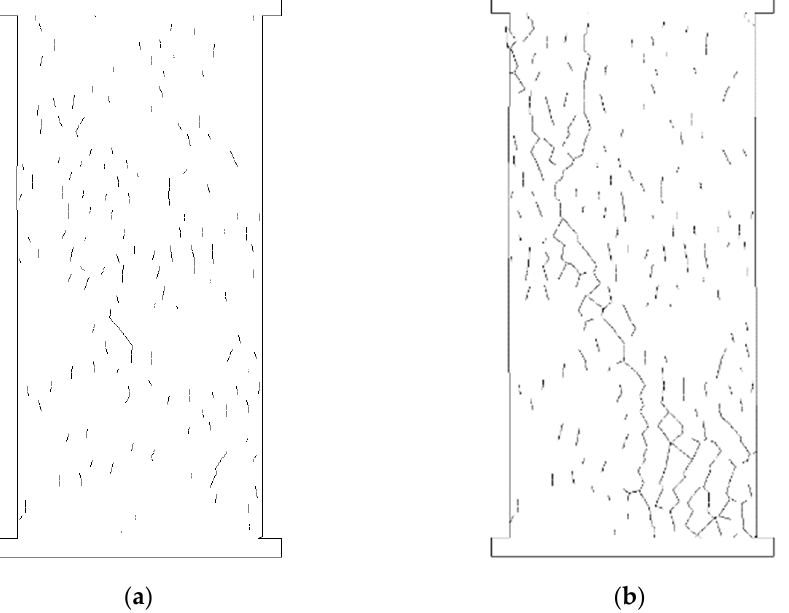
Figure 12. Contacts with damage above 0.9: ( a ) before peak, at vertical strain of 3.5 × 10 − 3 ; ( b ) after peak, at vertical strain of 3.7 × 10 − 3 .